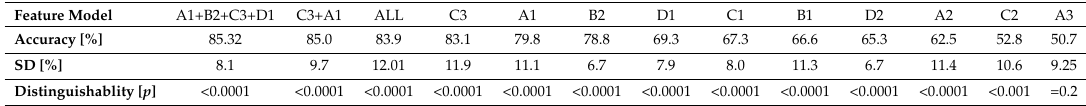
Table 1. Model performance (selected classifier: Linear Discriminant Analysis (LDA)).